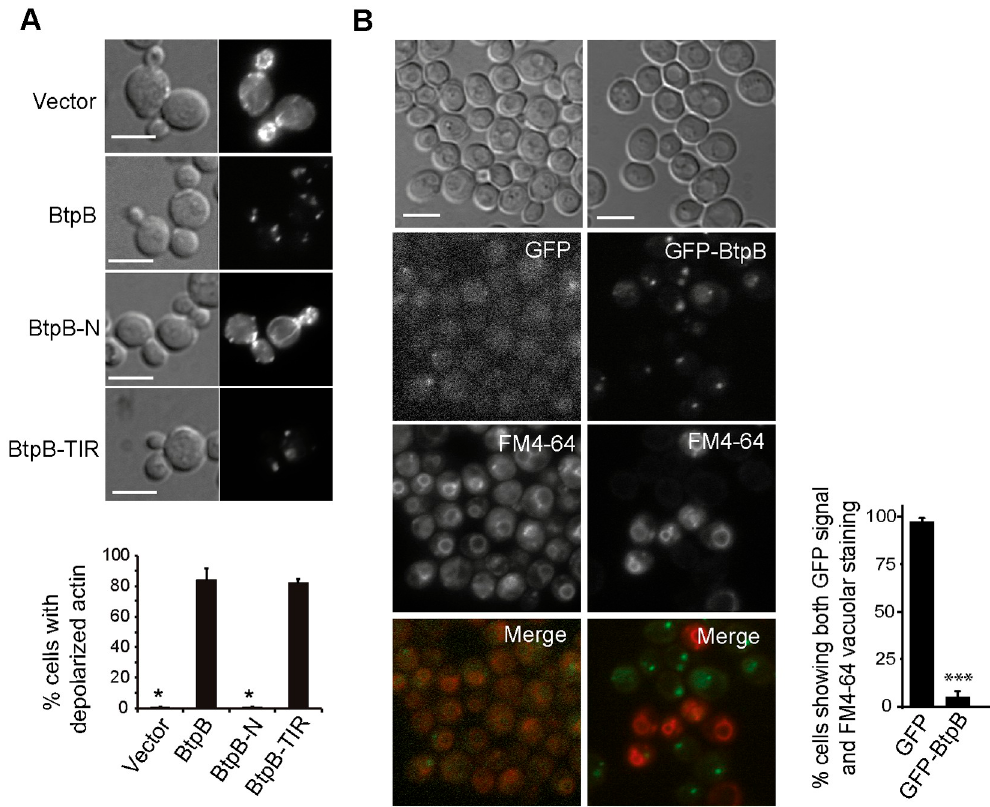
Fig 2. BtpB expression causes severe defects in actin cytoskeleton and endocytosis in S . cerevisiae . (A) Nomarski and fluorescence microscopy images (upper panel) and graph showing the percentage of small- to medium-budded cells with depolarized actin (lower panel) after rhodamine-phalloidin staining of YPH499 cells expressing pYES2-GFP empty vector, BtpB, BtpB-N or BtpB-TIR from pYES2-GFP plasmid derivatives after 4h induction. Data correspond to means ± standard deviation of three independent transformants (n � 100) and statistical comparison was done with Kruskall-Wallis ANOVA with p-values referring to BtpB of 0.024 ( � ) for vector and BtpB-N. Scale bars indicate 5 μ m. (B) Nomarski and fluorescence microscopy images (left panel) and graph representing the percentage of cells showing both GFP and FM4-64 vacuolar signal (right panel) of YPH499 cells expressing pYES2-GFP or pYES2-GFP-BtpB, after 4h induction, stained with the endocytic marker FM4-64 for 1h. Data correspond to means ± standard deviation of three independent transformants (n � 100) and statistical comparison was done with Student´s t-test, p < 0.0001 ( ��� ). Scale bars indicate 5 μ m.